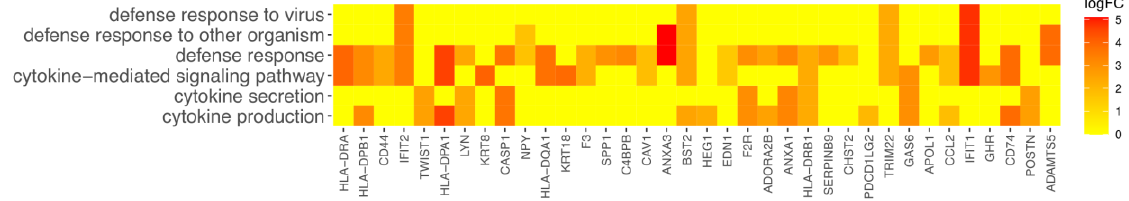
Figure 5. Heatmap presenting the relationship between genes and selected GO BP terms. The yellow tiles indicate the absence of logFC values.